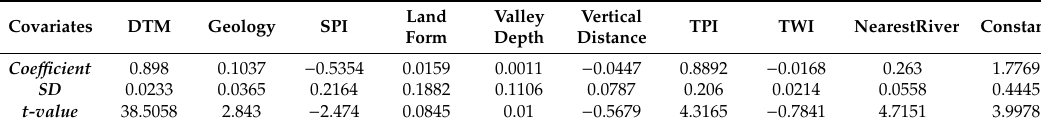
Table 5. Coe ffi cient calculation results using 50% data.